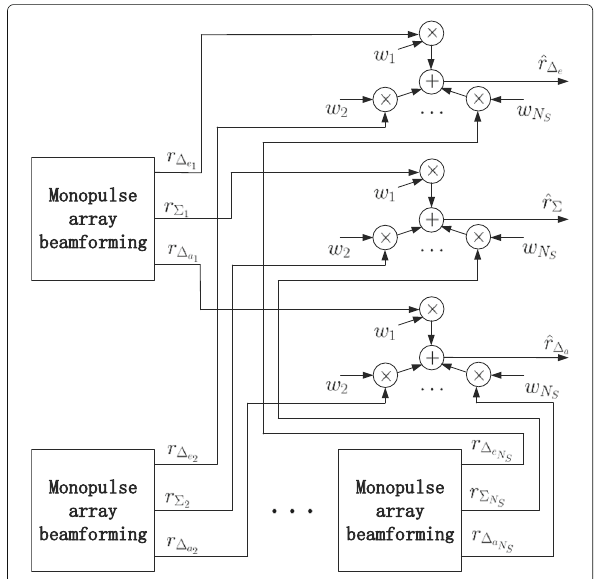
Fig. 3 Performing MLC simultaneously on (cid:2) , (cid:3) e , and (cid:3) a beams of DMA